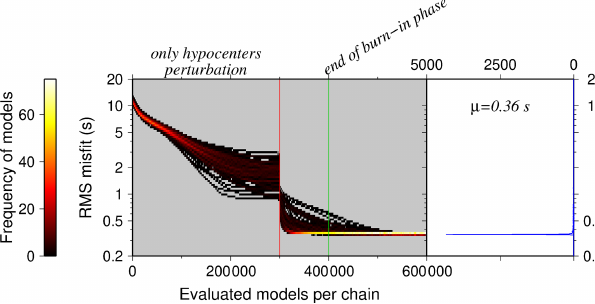
Figure 8. On the left histogram, the rms misfit along Markov chains during the inversion evolution is shown (color indicates number of models; please see color palette table on the left). Before the red line (300000 models), only the hypocenters are perturbed and beyond that the V P , V P /V S ratio, station corrections, and noise levels are allowed to change as well. The green line indicates the end of the burn-in phase after ∼ 400000 models. On the right histogram, the rms misfit for all the models after burn-in phase is shown. The best- fitting models are characterized by an average 0.36s rms